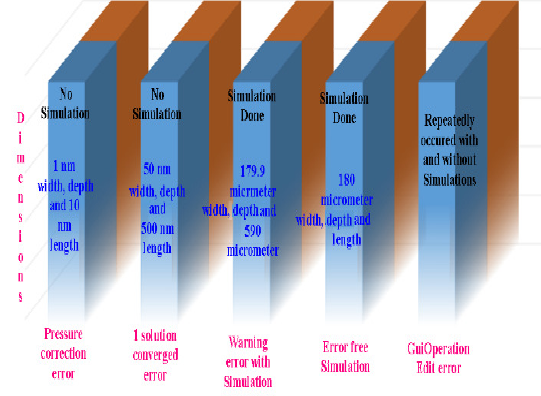
Fig. 14: Graphical summary of simulation for straight square